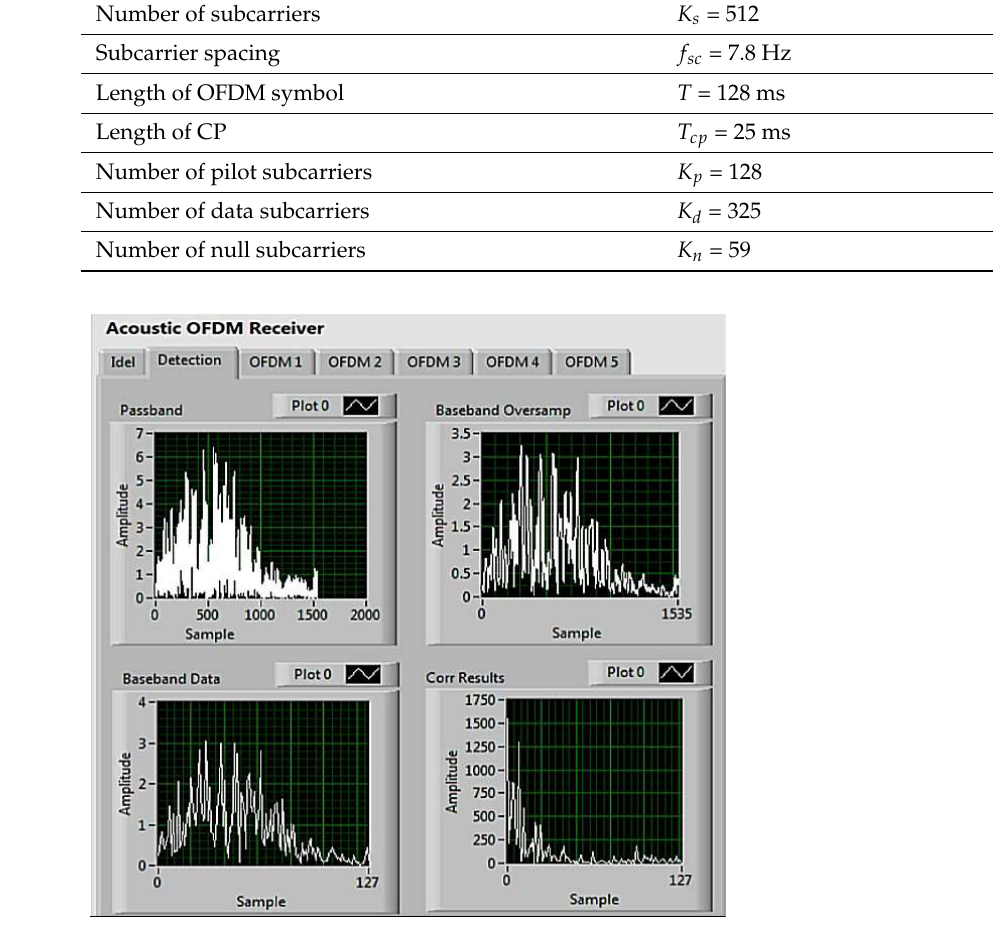
Figure 11. Received data frame in acoustic OFDM receiver during the tank experiment.